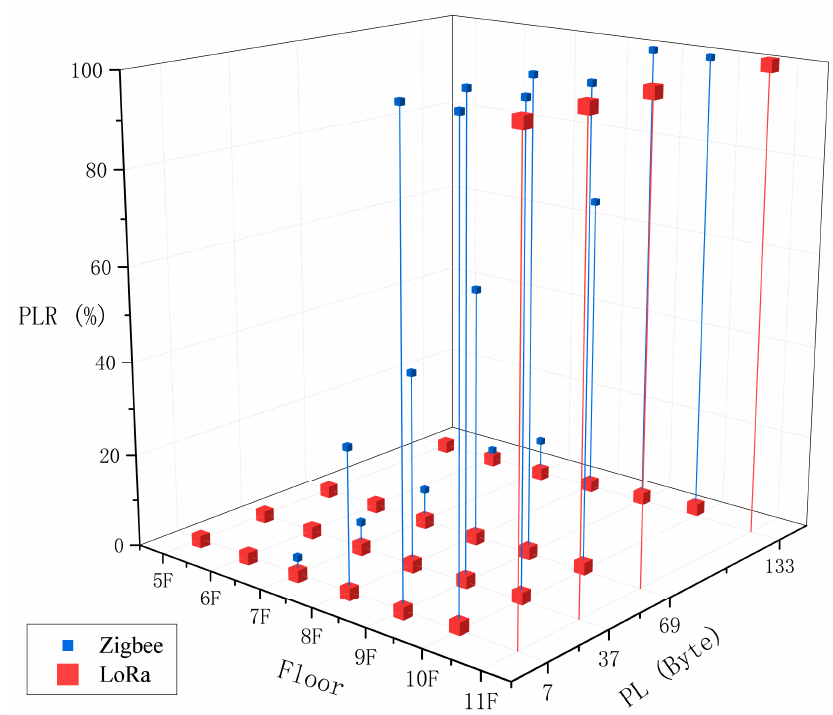
Figure 11. Test results of PLR in central position.